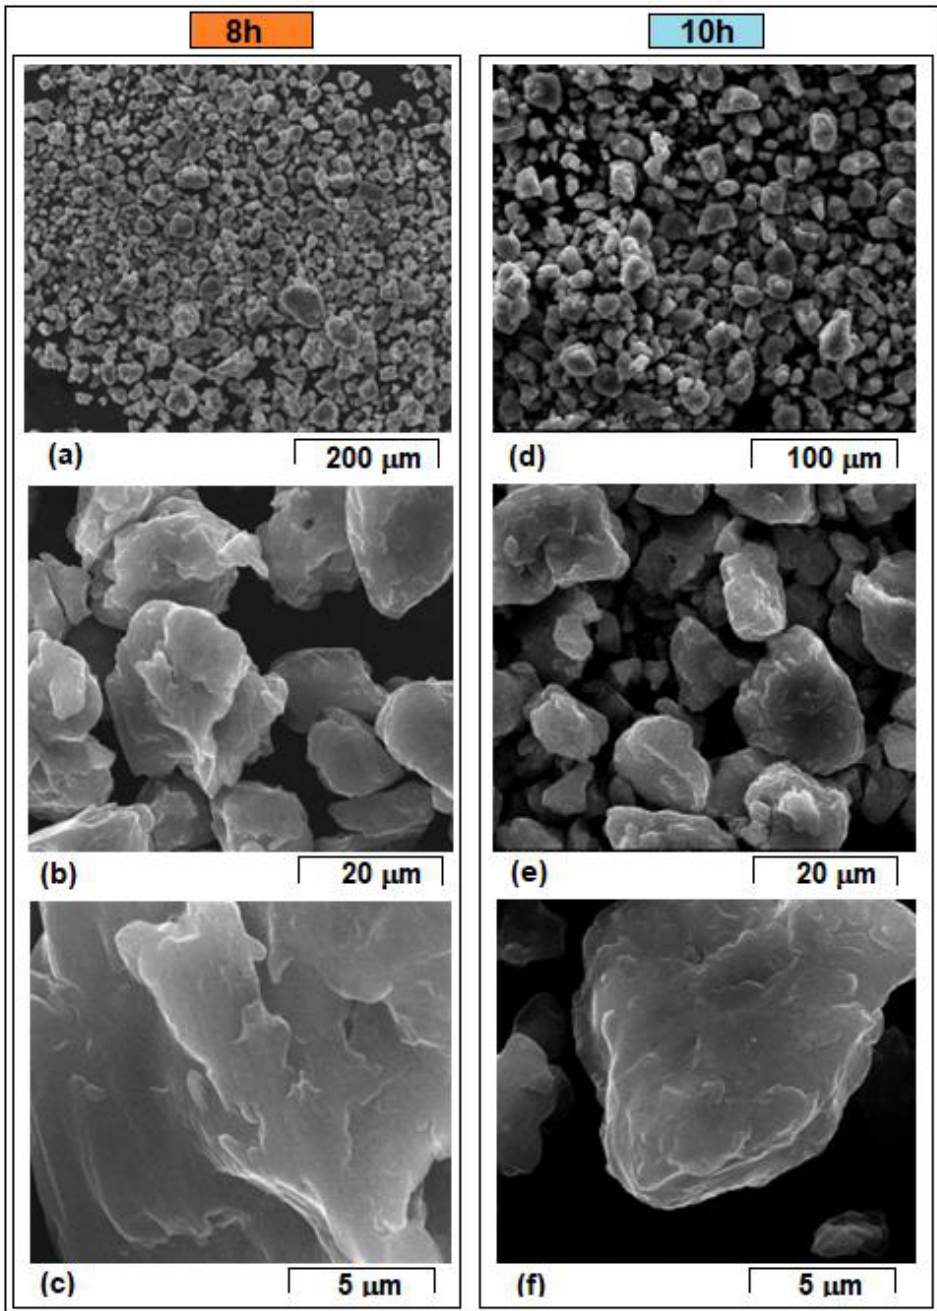
Figure 6. SEM images of the powder-alloy samples processed by mechanical alloying for different milling time: ( a – c ) 8 h/300 rpm, and different magnifications; ( d – f ) 10 h/300 rpm, and different magnifications; different